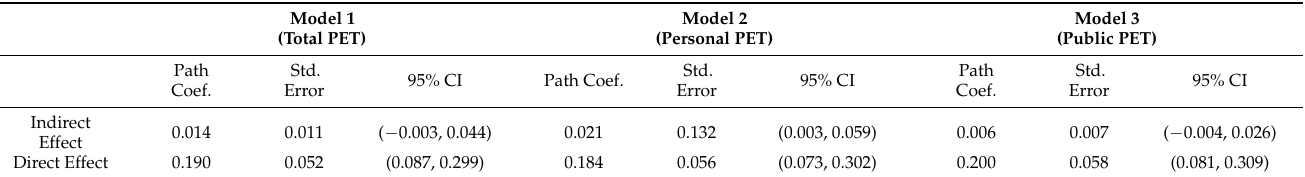
Table 7. Mediation Analysis.